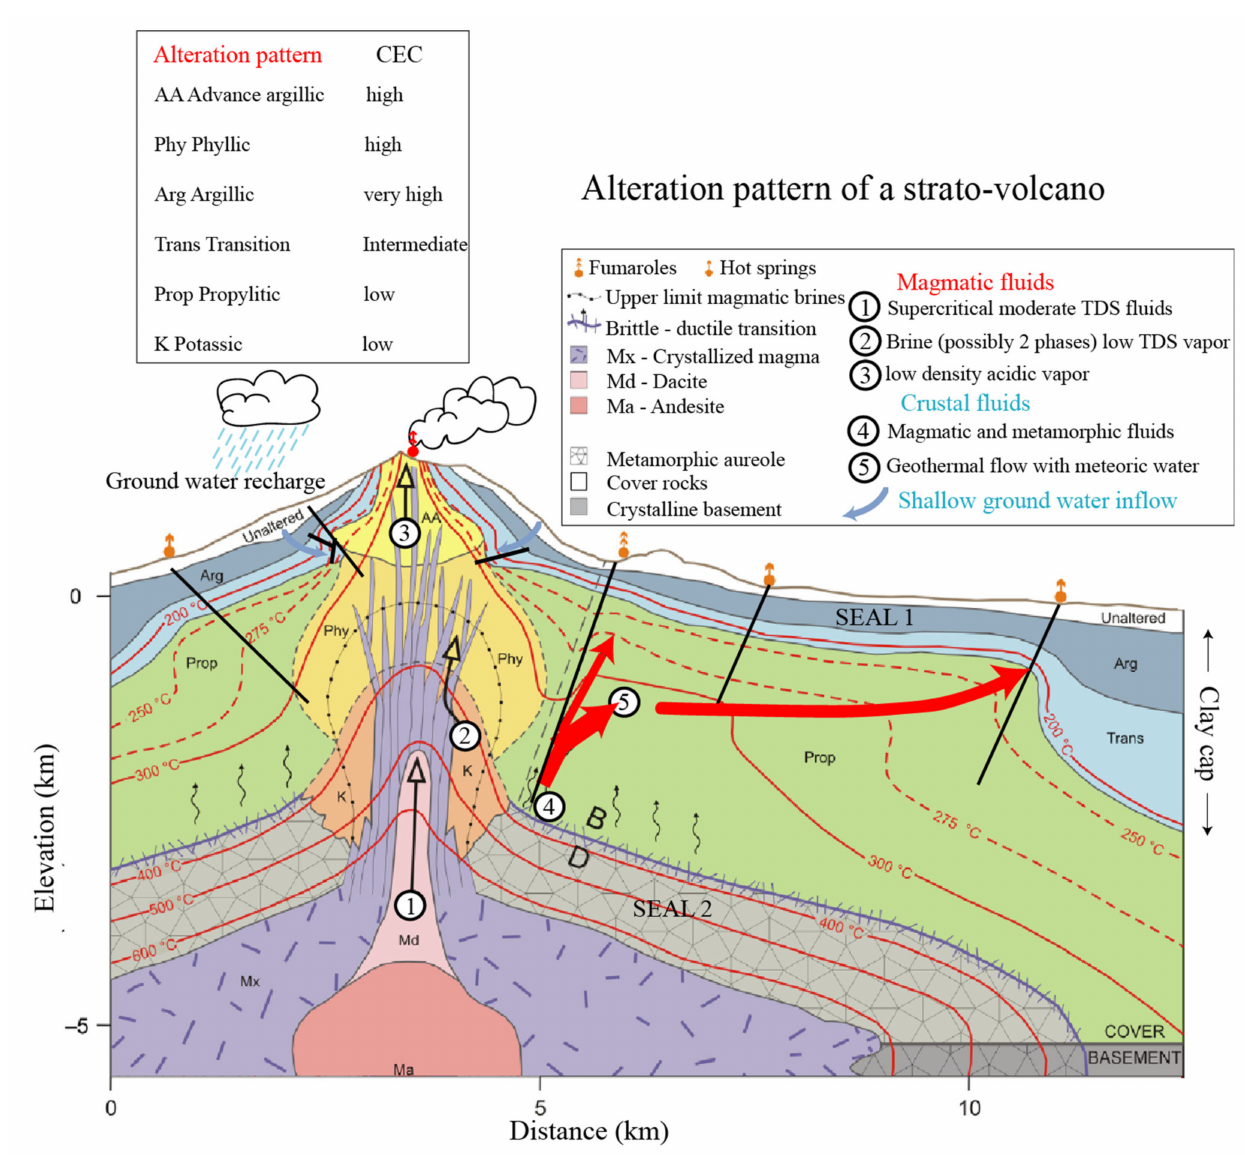
Figure 1. Sketch of the cross-section of a strato-volcano. Adapted from Stimac et al. [48] and Richards [49]. Induced polarization can be used to decipher the alteration pattern in such an environment, which has implication regarding the mechanical stability of volcanic edifices and phreatic and phreatomagmatic eruptions. SEAL1 corresponds to the smectite-rich clay cap. The shallow water table is located above this layer. SEAL2 corresponds to the permeability barrier associated with the brittle-ductile transition zone around the magmatic body. CEC stands for Cation Exchange